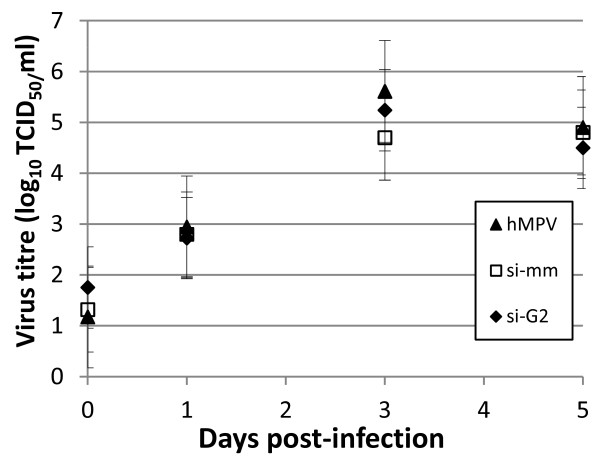
The effect of siG2 and siMM transfection 6 h prior to infection of A549 cells with hMPV at a MOI of 0.1. Viral supernatants were collected on the indicated days and the shed hMPV quantified using immunostaining and expressed as TCID50/ml. A significant reduction in G mRNA did not affect hMPV shed over 5 days pi.